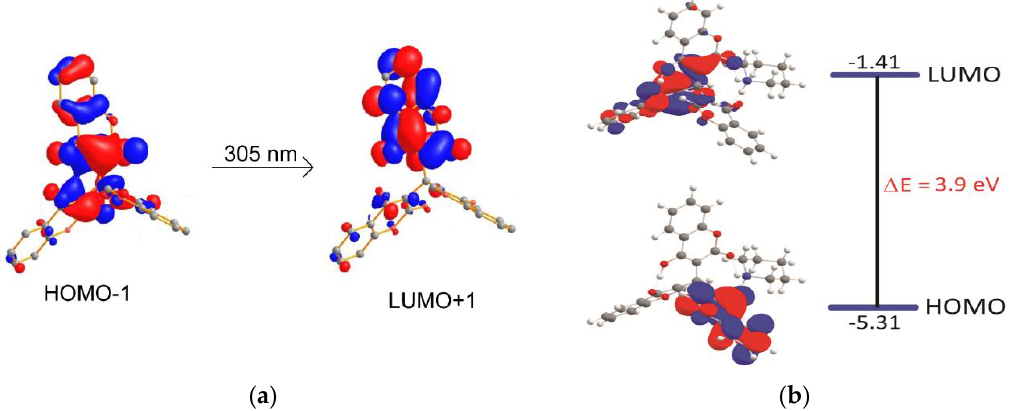
Figure 6. ( a ) Frontier molecular orbitals (FMO) involved in electronic transitions observed in TDDFT calculated UV-vis spectrum of compound 4 . ( b ) Energy diagrams and Kohn–Sham orbitals of compound 4 . Value of contour envelopes is 0.03 au.